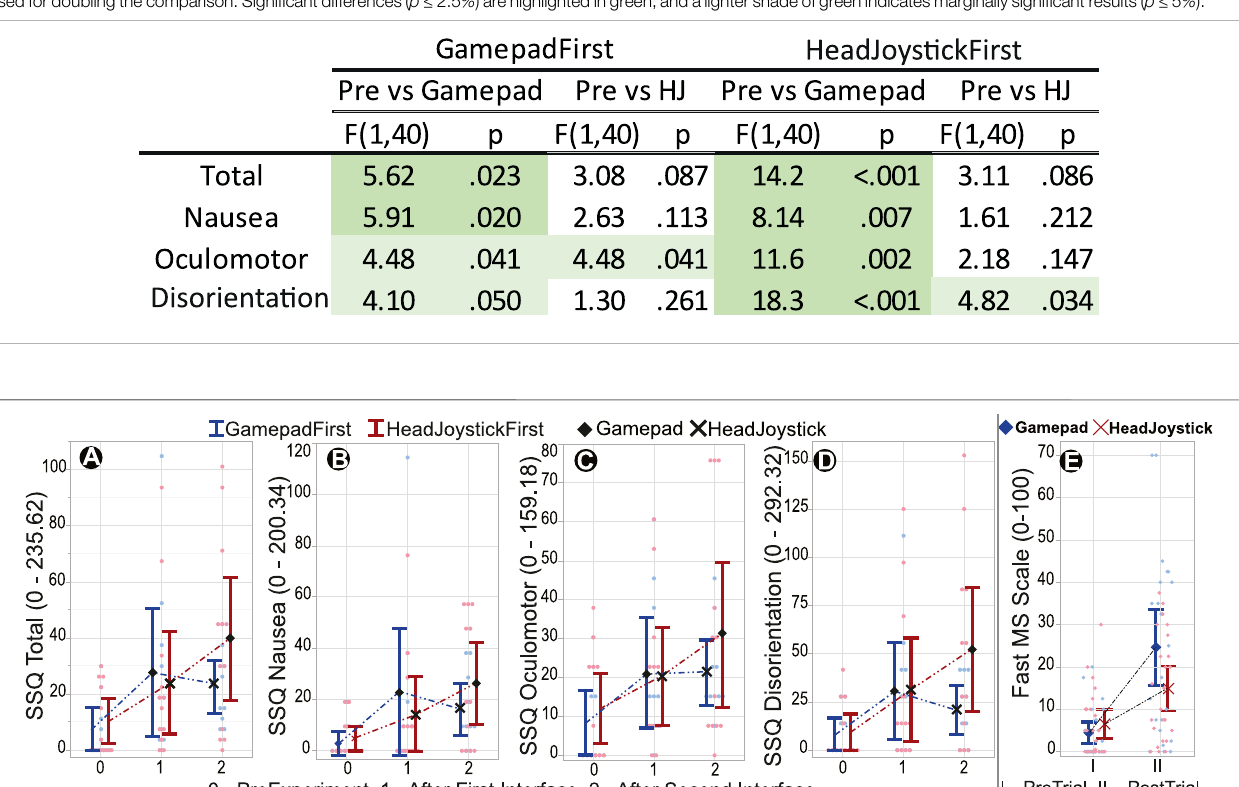
Frontiers in Virtual Reality |